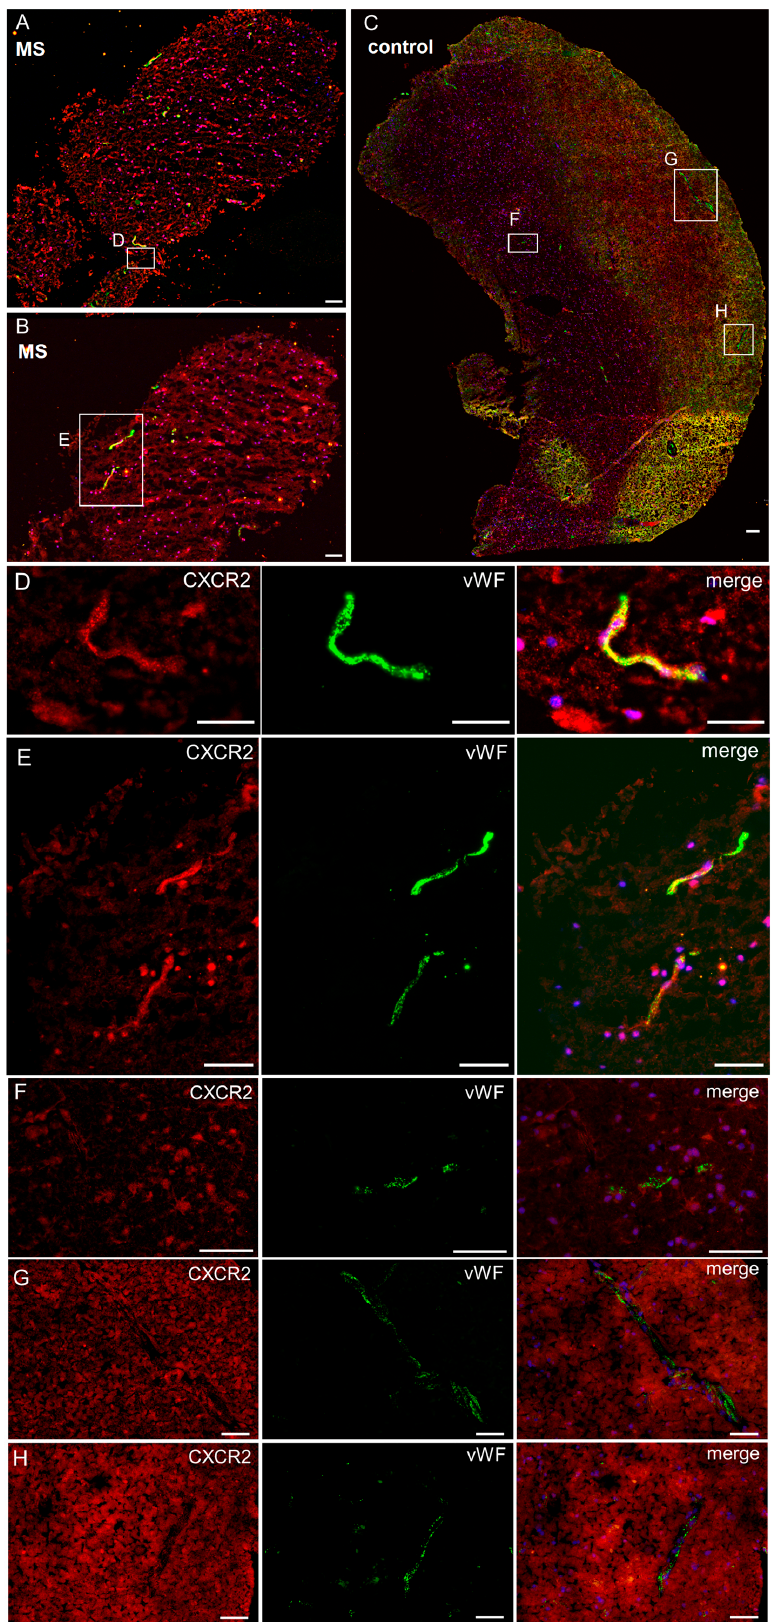
Figure 2. Inflammation-induced upregulation of CXCR2 in human brain tissue. Cryostat sections of stereotactic biopsies from an acute multiple sclerosis (MS) lesion ( A , B , D , E ) or non-inflamed human brain ( C , F – H ) with immunofluorescence double staining for CXCR2 (red) and the endothelial marker protein von Willebrand factor (vWF) (green). In MS plaques, 116/157 [74%] vessels were CXCR2-positive, while in healthy tissue only 24/104 [24%] vessels were CXCR2-positive ( p < 0.0001, Fisher’s exact test). Scale bar 50 µ